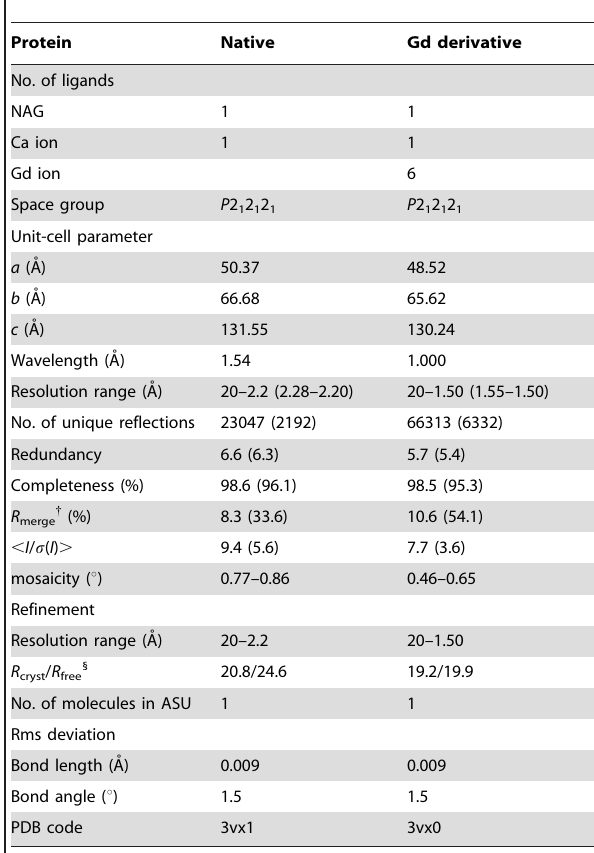
Table 2. Data-collection and refinement